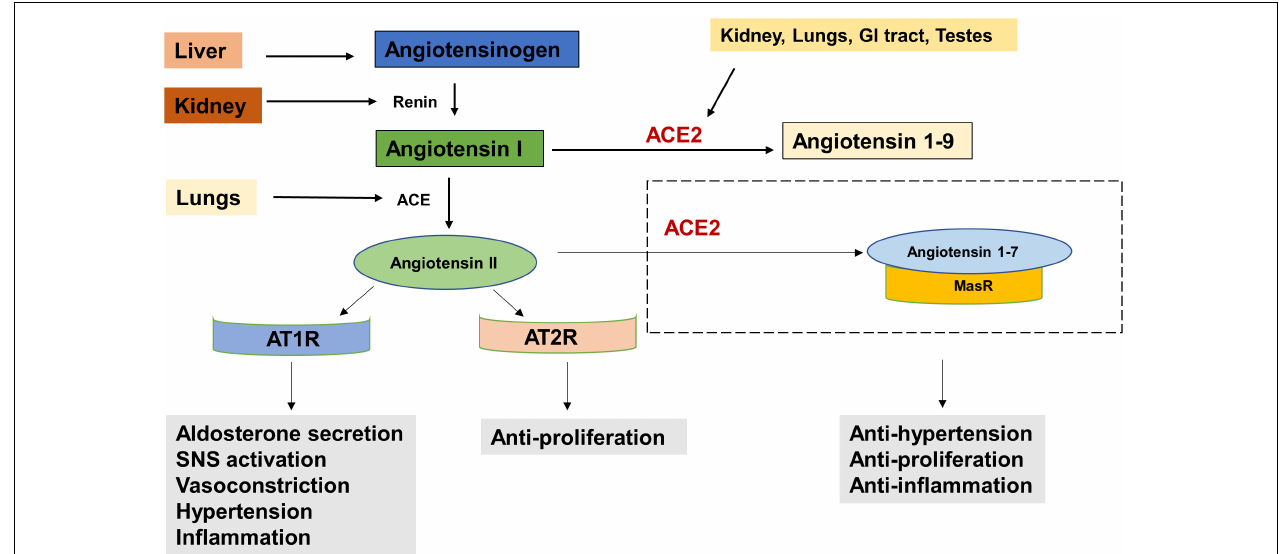
FIGURE 2 | The Renin Angiotensin System (RAS). Reduced blood pressure results in the release of Renin from the kidneys which converts Angiotensinogen to Angiotensin I. Angiotensin I is physiologically inactive and a precursor to Angiotensin II. Angiotensin Converting Enzyme (ACE), produced by the lungs cleaves Angiotensin I to Angiotensin II. The binding of Angiotensin II to Angiotensin receptor Type I (AT1R) results in increased aldosterone secretion, Sympathetic Nervous System (SNS) activation, vasoconstriction, increased blood pressure and inflammation. Its binding to Angiotensin receptor Type II (AT2R) has anti-proliferative effects.